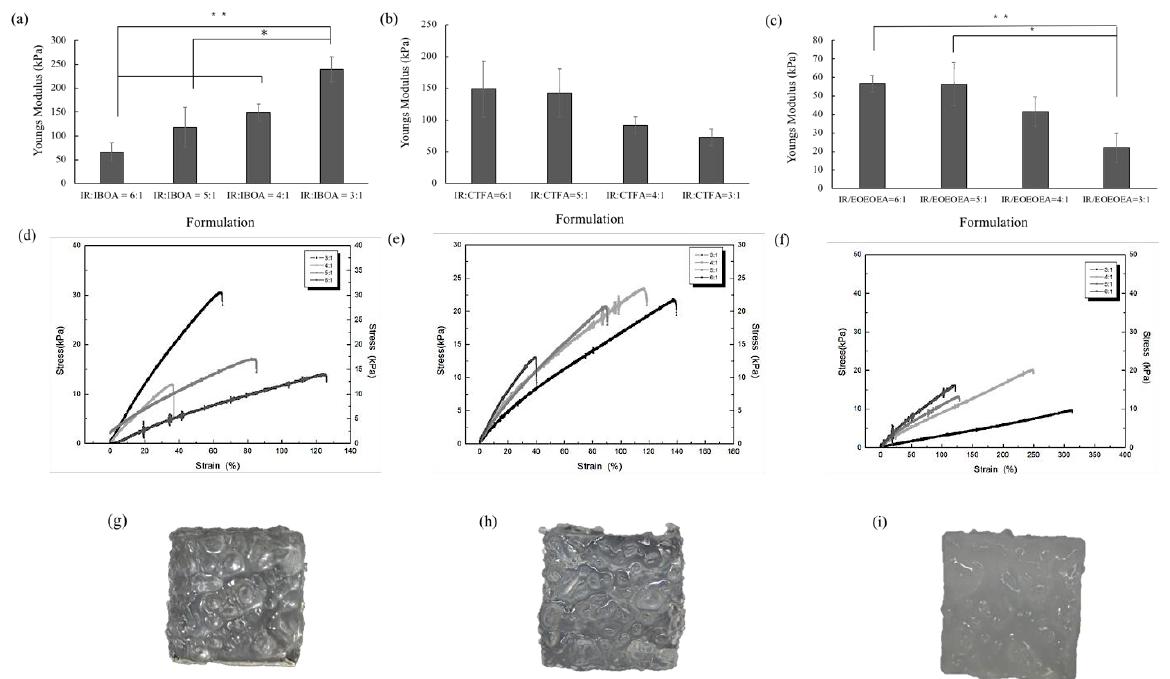
Figure 2. The Young’s modulus, stress-strain curves and 3D printing schematic of stomach simulation of cis -1,4 polyisoprene (IR) and three diluent monomers. ( a – c ) Comparing the mechanical properties of polyisoprene mixed with IBOA, CTFA, and EOEOEA in different proportions (( a ) IR/IBOA, ( b ) IR/CTFA, ( c ) IR/EOEOEA). The significant difference between resin formulations was indicated by * ( p < 0.05) and ** ( p < 0.01). ( d – f ) The stress-strain curves of IR and three diluent monomers (( d ) IR/IBOA, ( e ) IR/CTFA, ( f ) IR/EOEOEA). ( g – i ) Three-dimensional printing schematic of stomach simulation ( g ) IR/IBOA, ( h ) IR/CTFA, ( i ) IR/EOEOEA.